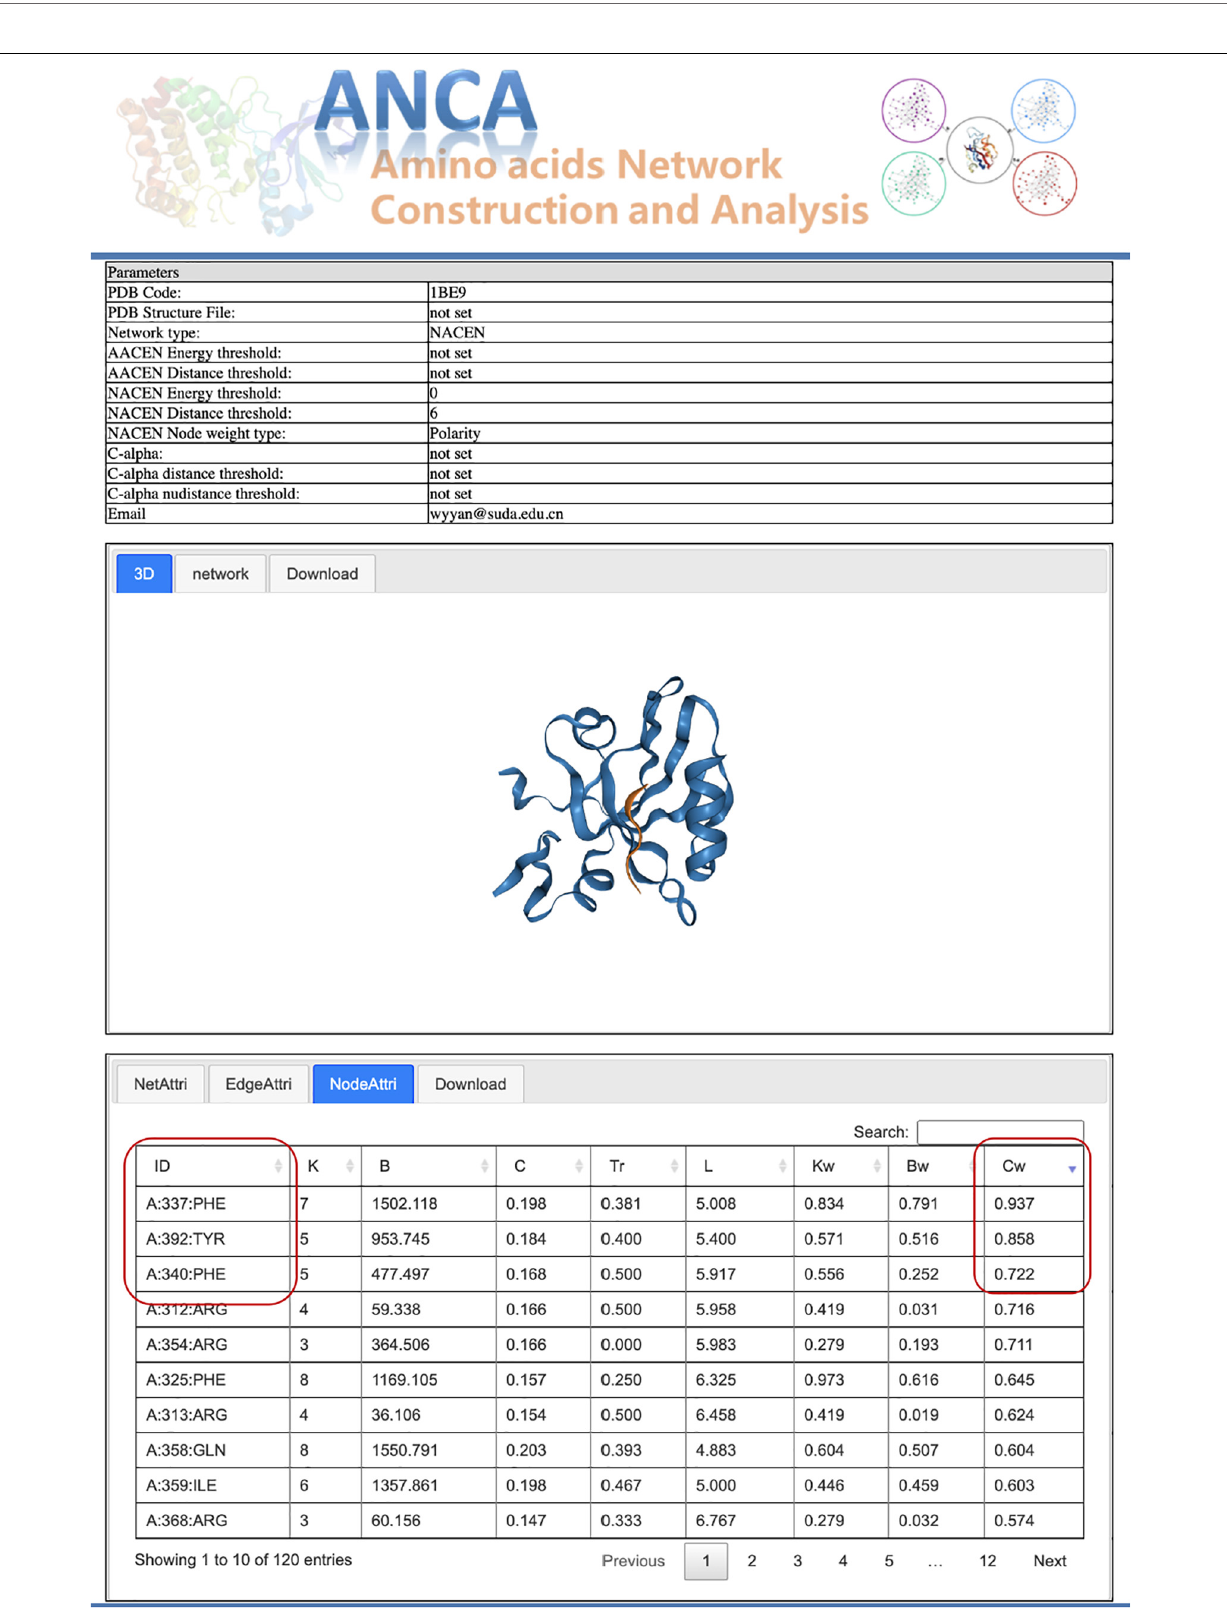
FIGURE 3 | Results page for the case